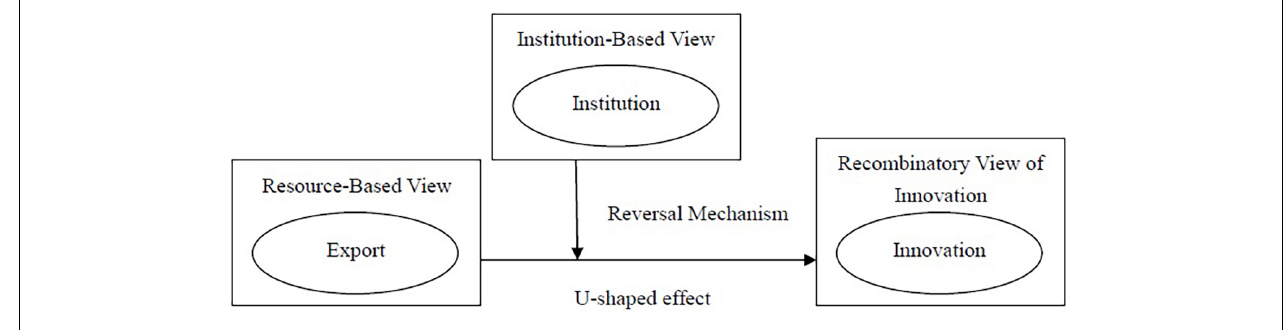
FIGURE 1 | Conceptual